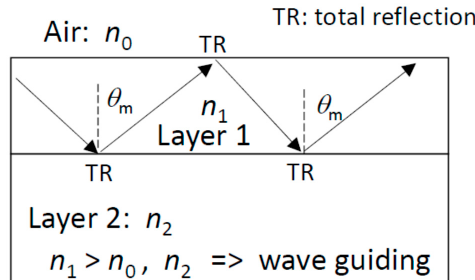
Figure 1. Schematically depicted cross-section of a slab waveguide consisting two layers: An upper layer with higher refractive index and lower one with lower index. Air (or vacuum) on the upper layer acts as a cladding layer. At light-propagating angles at discrete values, the total reflections are induced at the boundaries between air and the layer 1 and between layers 1 and 2. Consequently light in the layer 1 is confined inside of the layer 1 and guided along the inside of the layer.